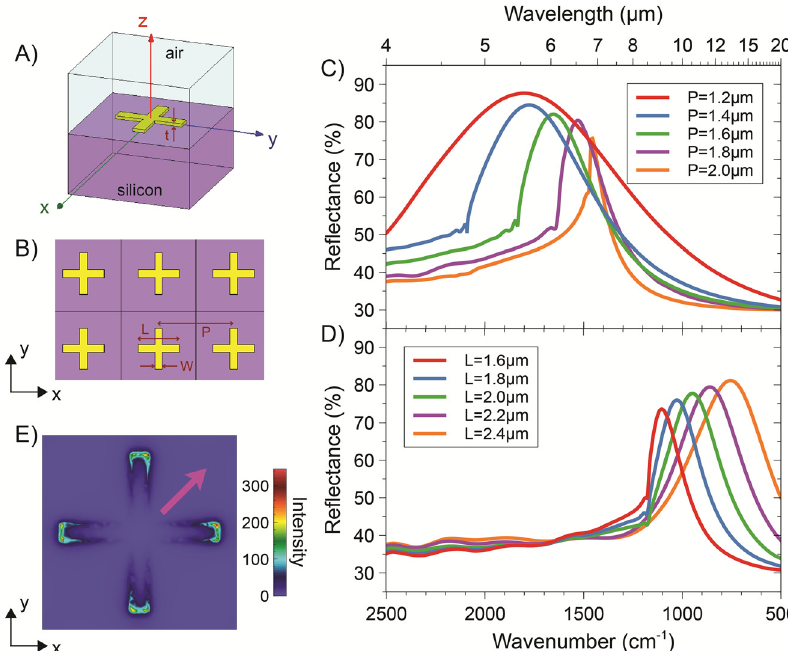
Figure 1: Representative numerical results for CS-type NAs. (A), (B) 3-D schematic of the unit cell and square periodic lattice, respectively, with indication of the geometrical parameters. (C) Reflectance responses,asafunctionofthewavenumber (and wavelength, on the top axis), for a normally incident plane-wave illumination with x -polarized electric fi eld, width W = 200 nm and armlength L = 1.1 µm, and various values of the period P. (D) As in panel (C), but for fi xed P = 2.5 µm, and various values of L. (E) Electric- fi eld distri- bution (intensity, in false-color scale, normalizedwithrespecttotheincidentone) over the unit cell, for L = 2.0 µm and P=2.5µm,computedatadistanceof10 nm (along z ) from the NA at the resonance (wavenumber: 947 cm − 1 ). The magenta thick arrow indicates the polarization of the impinging electric fi